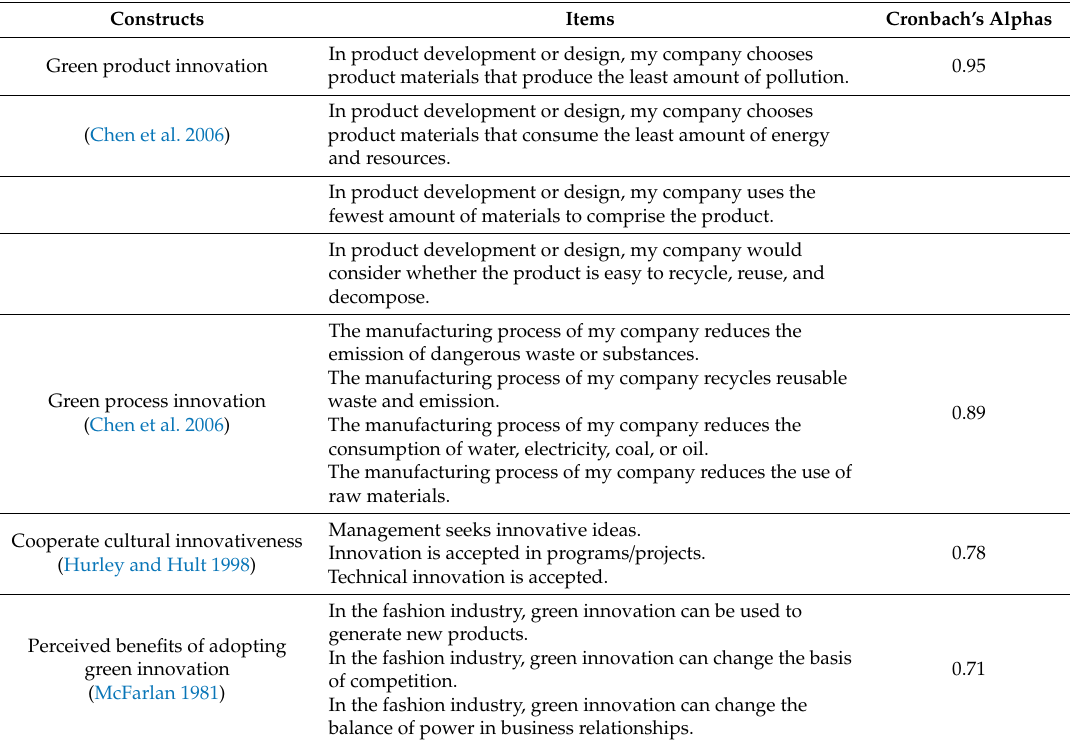
Table 2. Items Used to Measure the Constructs and Cronbach’s Alphas.